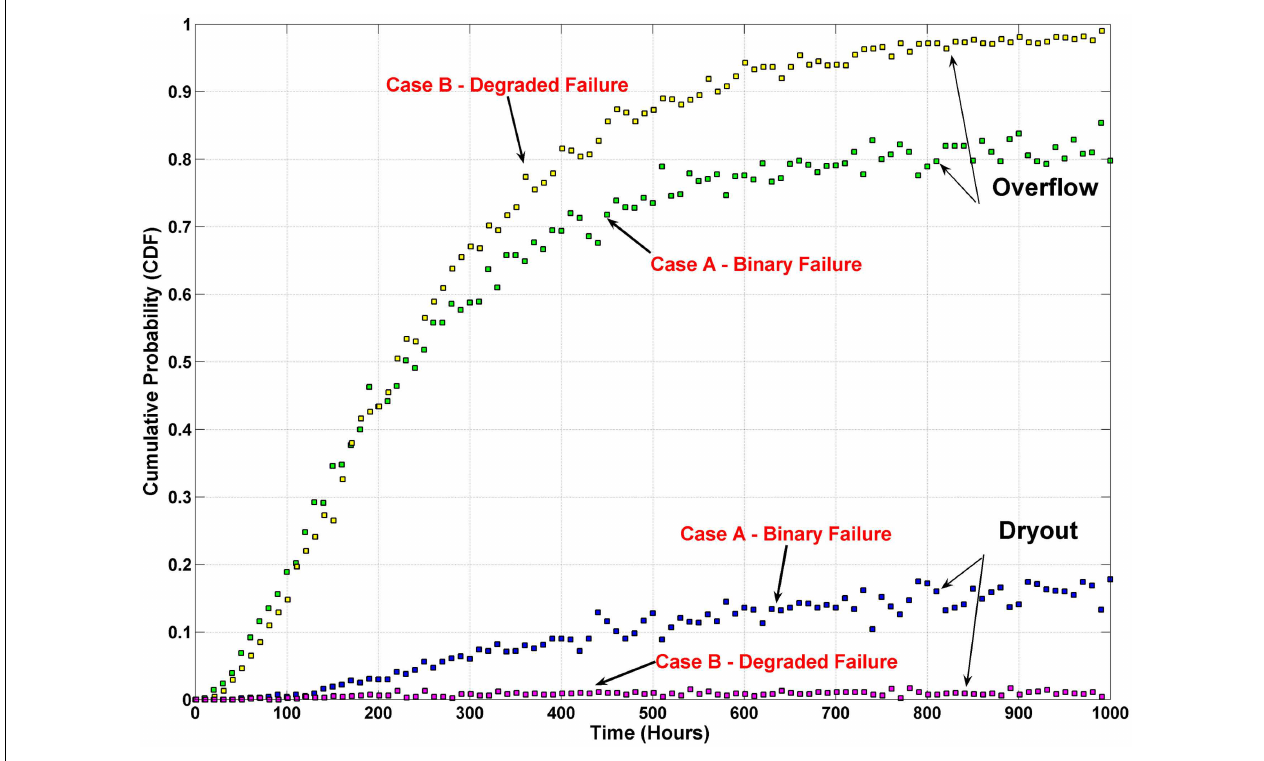
FIGURE 4 | Cumulative probability plot of benchmark problem